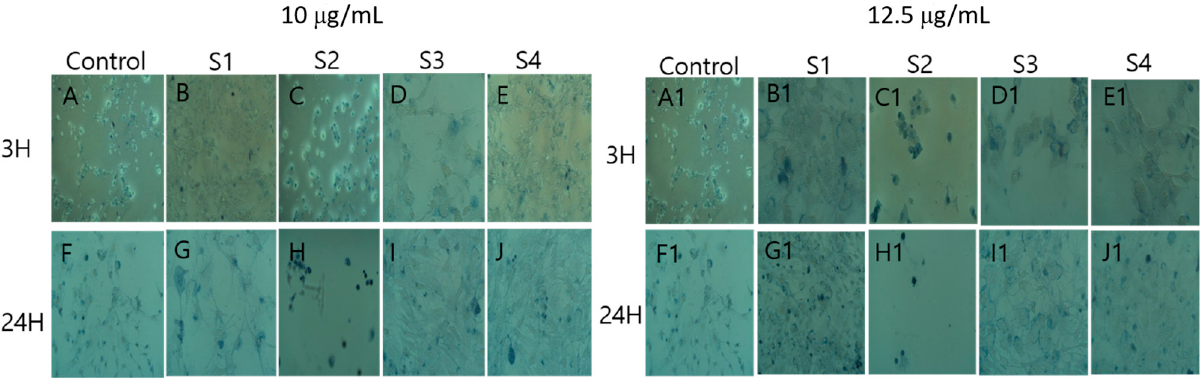
Figure 9. Trypan blue cell viability images for control, (S1) DM extract, (S2) DM-ZnO-NPs, (S3) DM-ZnO-Try–NE and (S4) Tryptophan at 10 μ g/mL ( A – J ) and 12.5 μ g/mL ( A1 – J1 ) for 3 h and 24 h time point at 20× magnification.